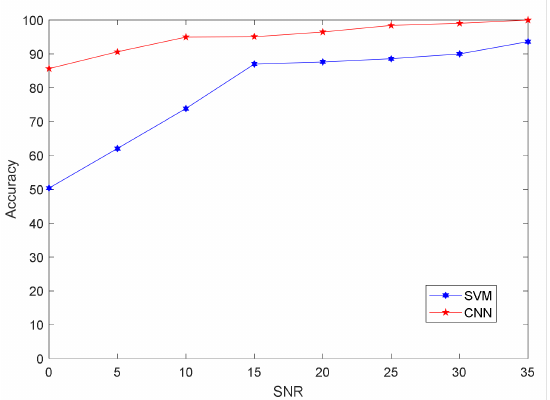
Figure 8. Accuracy of ASK signal features under different signal-to-noise ratio conditions through CNN and SVM classifiers.